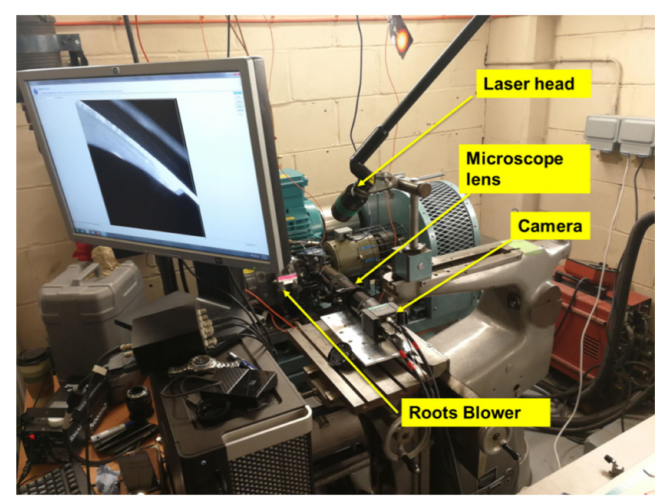
Figure 3. Roots blower test rig with microscope